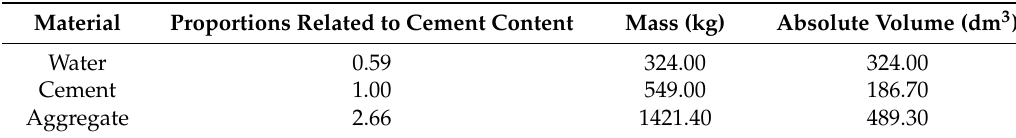
Table 1. Mortar components and proportions for 1 m 3